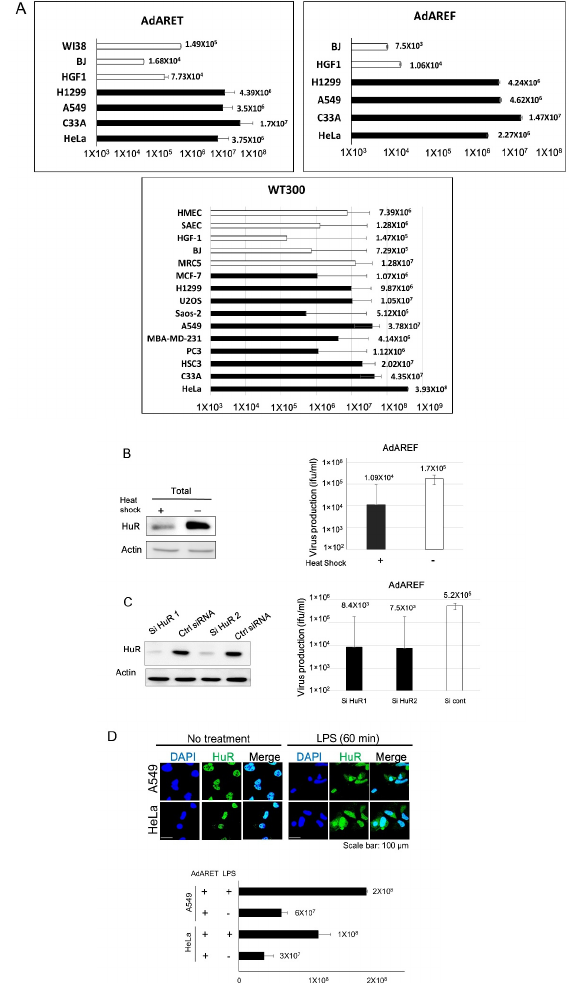
Figure 2. Productive e ffi ciency and HuR dependence of AdARET and AdAREF. ( A ) Cancer (HeLa, H1299, A549, and C33A) and normal (BJ, HGF1, and WI38) cells were infected (72 h of infection) with AdARET and AdAREF at an MOI of 100 vp / cell, and the titer of the virus was determined by hexon staining in 293 cells. (upper) Cancer (MCF-7, H1299, U2OS, Saos-2, A549, MBA-MD-231, PC3, HSC3, C33A, and HeLa) and normal (HMEC, SAEC, HGF1, BJ, and MRC5) cells were infected (48 h of infection) with WT300 at an MOI of 10 ifu / cells, and titers were estimated. (lower) Each titer is indicated on the graph. ( B ) AdAREF-infected A549 cells were exposed to heat shock at 43 ◦ C for 2 h and HuR expression was subsequently detected by western blot analysis. β -actin expression was used as loading control. (left) Each virus titer was estimated using the same method described in ( A ). (right) ( C ) A549 cells were transfected with an siRNA targeting HuR and a negative control siRNA and the expression of HuR was estimated by western blot analysis. (left) HuR KD-A549 cells were infected with AdAREF, and viral titers were determined as described in ( A ). (right) ( D ) The cytoplasmic HuR level was also estimated by confocal microscopy. HeLa and A549 cells were treated with LPS and then stained using an anti-HuR antibody, as described. In all cases, cell nuclei were visualized by staining with DAPI. Bars indicate 100 µ m. Data shown are from a single experiment representative of three repeats giving similar results. (top) To assess the e ff ect of LPS for viral replication, A549 and HeLa cells were treated with LPS and infected with AdARET, then the viral titers were determined as described in ( A ). Each titer (ifu / mL) is shown on the graph. Data are shown as the mean ± standard deviation of three independent experiments (bottom). The uncropped blots and molecular weight markers are shown in Figure